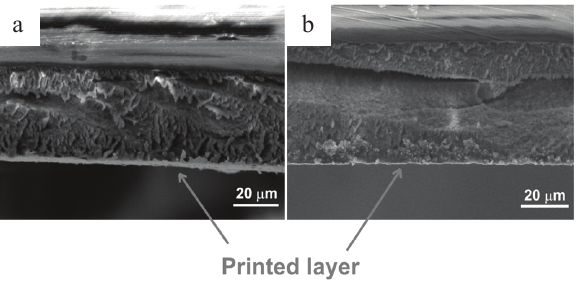
Fig. 6 – Thickness of PMA-AgNP printed layers sintered at different temperatures for 20 min and for different durations at 120 °C, obtained by scanning electron microscopy of cross-sec - tion